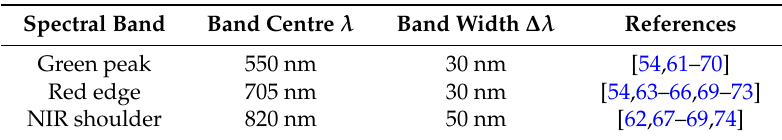
Table 1. Three optimal wavebands for vegetation mark detection and some references supporting this claim.